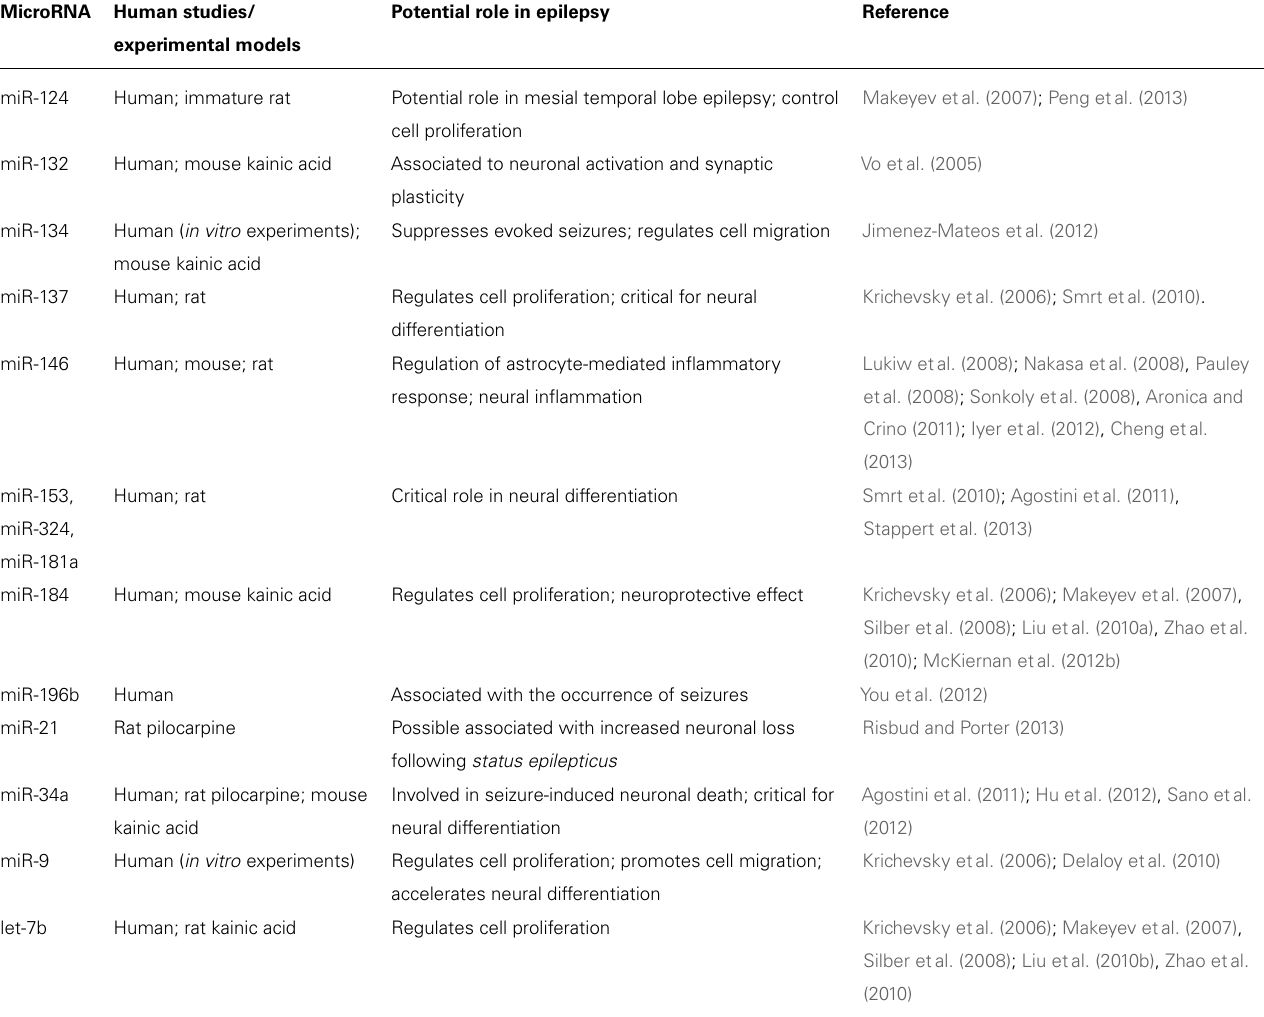
Table 1 | MicroRNAs potentially involved in